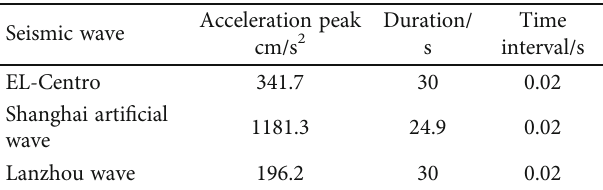
Figure 2: Light steel-wood-plastic structure model. Table 2: Selected seismic wave